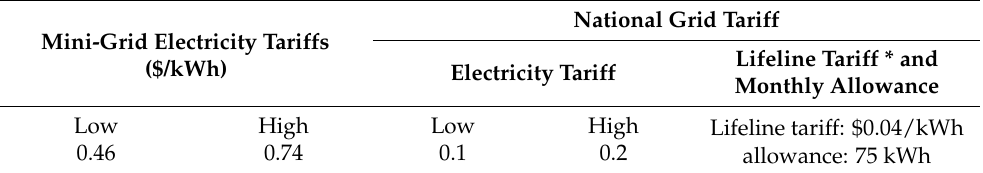
Table 3. Electricity tariff.